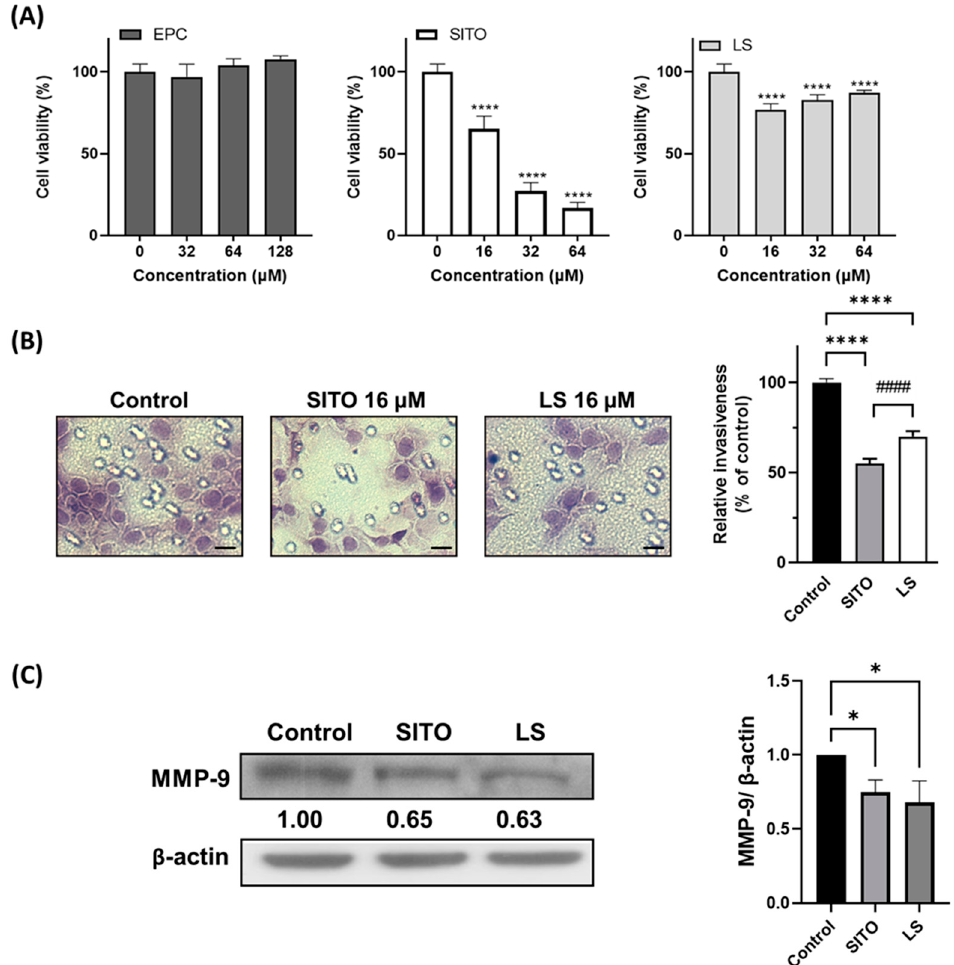
Figure 2. Changes in cell viability, invasiveness, and MMP-9 of the CT26/ luc cells caused by different treatments. ( A ) CT26/ luc cells were treated with various concentrations of EPC, β -sitosterol (SITO), and liposomal β -sitosterol (LS) for 72 h and subjected to the MTT assay. Each point represents the mean ± SE of three independent experiments. ( B ) Invasiveness of the CT26/ luc cells was determined using Matrigel-coated Transwell inserts after being treated with the vehicle, SITO, and LS for 3 days. The vehicle-treated controls were set as 100%. Photos were taken with 40 × magnification. Scale bar = 20 µ m. ( C ) Expression of MMP-9 in the vehicle, SITO, and LS-treated CT26/ luc cells was analyzed by Western blot. All experiments were independently performed three times. (* p < 0.05 and **** p < 0.0001 compared with the Control; #### p < 0.0001 compared with SITO).